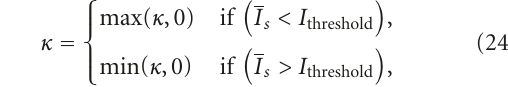
The evolution speed is switched between min( κ ,0) and max( κ ,0), and di ff usion is turned on or o ff depending the scale of the noise that wants to remove. κ is simplified as